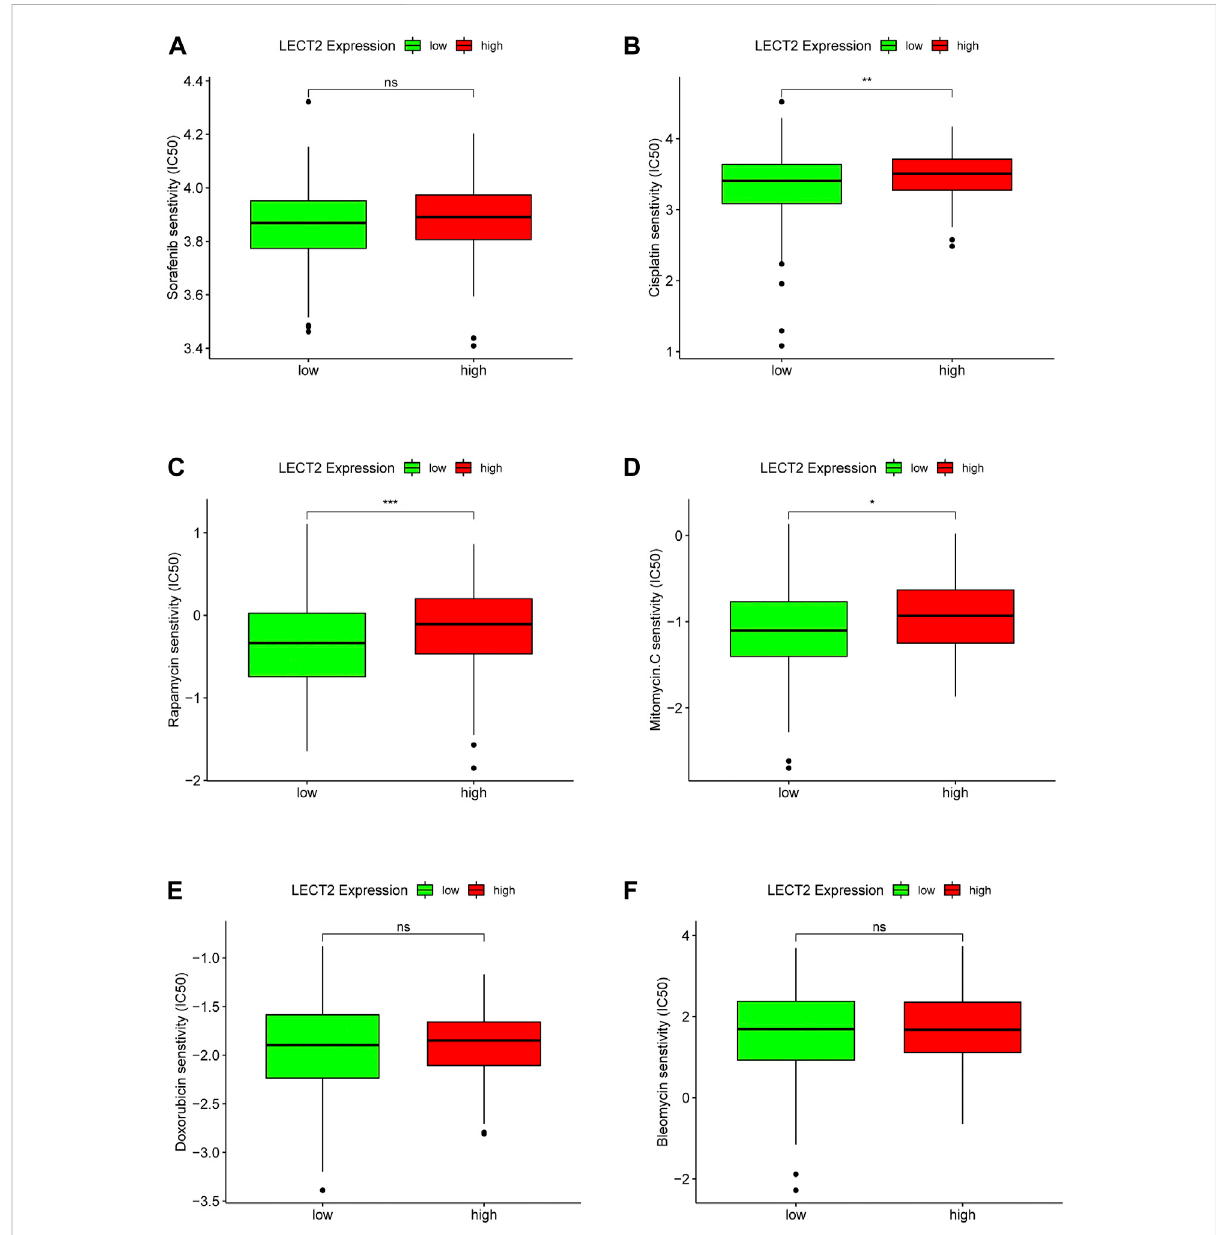
FIGURE 10 Correlation analysis of LECT2 expression with chemotherapeutic drug sensitivity. Difference analysis of the sensitivity of six chemotherapeutic drugs (A) Sorafenib, (B) Cisplatin, (C) Rapamycin, (D) Mitomycin, (E) Doxorubicin, (F) Bleomycin in LECT2 high expression group and low expression group, green represents low LECT2 expression, red represents high LECT2 expression. “ ns ” represents no signi fi cance, "*" represents p < 0.05, "**" represents p < 0.01, and "***" represents p < 0.001